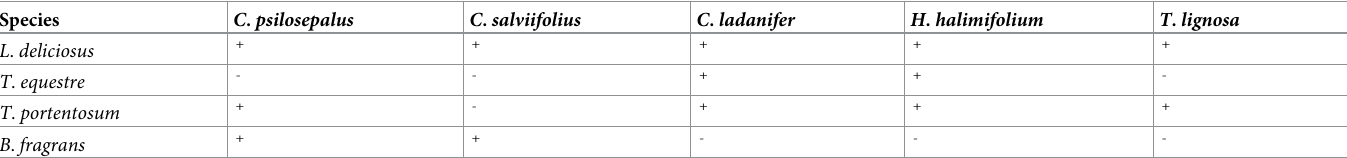
Table 2. Ectomycorrhizal establishment between the four species of fungi and five species of Cistaceae. “+”/“-” successful/unsuccessful establishment of ectomycorrhizas. Species